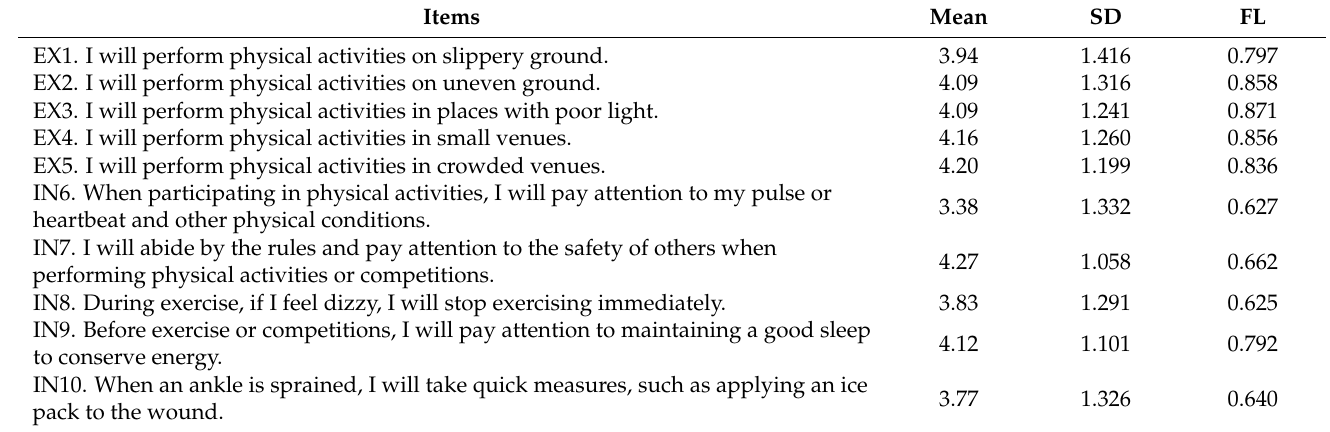
Table 3. EFA results for SIIEFSSI internal and external risk factor ( N =